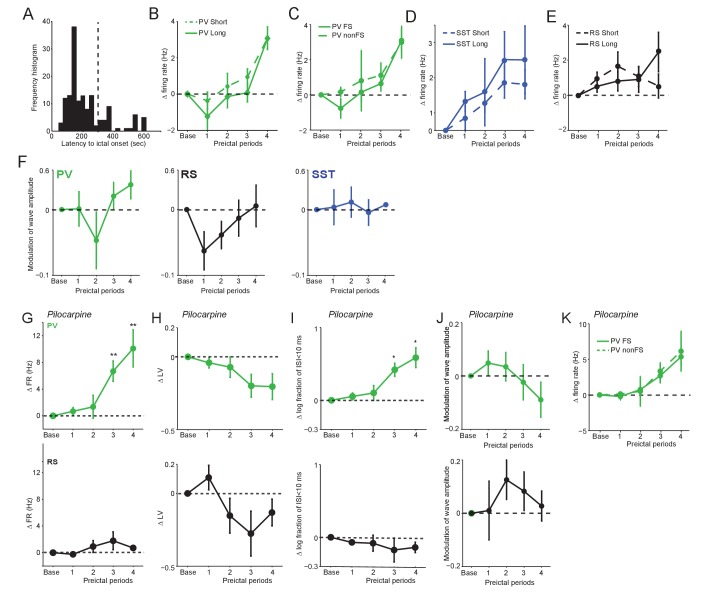
Spontaneous preictal firing rate trajectories.(A) Frequency histogram of latency to ictal onset (s) in acute PTZ seizure for all anesthetized experiments. (B) Mean ±SEM changes in PV firing rate (Hz) as compared to baseline over four preictal periods for seizures having either short (<300 s; n = 14) or long (>300 s;n = 4) latencies. (C) Mean ±SEM changes in PV fast-spiking (FS) and PV non-FS cell firing rate as compared to baseline (n = 24 PV FS and 9 PV non-FS). (D) Mean ±SEM changes in SST firing rate (Hz) as compared to baseline for seizures having either short (n = 24) or long (n = 7) latencies. (E) Mean ±SEM changes in RS firing rate (Hz) as compared to baseline for seizures having either short (n = 12) or long (n = 8) latencies. (F) Mean ±SEM modulation (defined as [a-b]/[a + b], where a is preictal and b is baseline) of spike waveform amplitude as compared to baseline over four preictal periods for PV(green), SST (blue), and RS (black) cells for acute PTZ seizures. None of the comparisons to baseline (dotted lines) reached statistical significance at p<0.0125. (G–K) Data from acute Pilocarpine seizure model. (G) Mean ±SEM changes in firing rate as compared to baseline over four preictal periods for PV (n = 10 cells in eight mice; upper, green) and RS (n = 6 cells in four mice; lower, black) cells. See Figure 1E for comparison with PTZ-model. Note that these changes occurred in the absence of significant changes in waveform amplitude. (H) Mean ±SEM changes in local variation (LV) of firing as compared to baseline over four preictal periods for PV and RS cells. See Figure 4A for comparison with PTZ-model. (I) Mean ±SEM changes in the log10-ratio of short inter-spike-intervals (ISI;<10 ms) over long ISI (>10 ms) intervals. Significance to baseline in all plots: *p<0.0125, **p<0.0025. (J) Mean ±SEM modulation (defined as [a-b]/[a + b]) of spike waveform amplitude as compared to baseline over four preictal periods for PV (upper, green) and RS (lower, black) cells for acute Pilocarpine seizures. None of the comparisons to baseline (dotted lines) reached statistical significance at p<0.125. (K) Mean ±SEM changes in firing rate as compared to baseline for fast-spiking (FS; n = 6) and non fast-spiking (nonFS; n = 4) PV interneurons over four preictal periods.